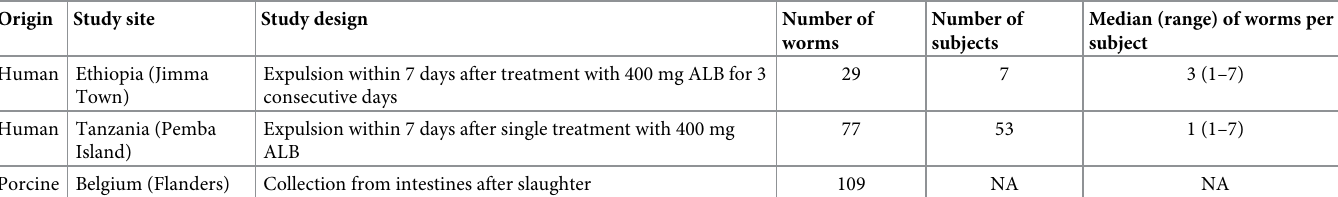
Table 1. Overview of origin of the adult Ascaris worms used for deep amplicon